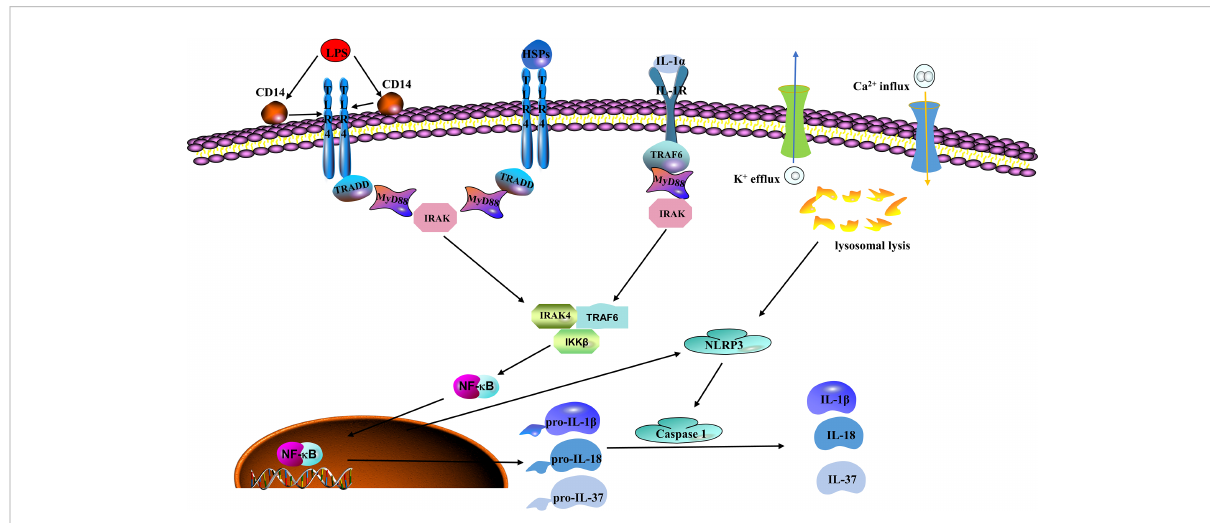
FIGURE 1 Classic mechanisms of in fl ammasome activation. Lipopolysaccharide (LPS), which is regarded as the prototype of pathogen associated molecular patterns (PAMPs) and heat shock proteins (HSPs) as a typical representative of damage associated molecular patterns (DAMPs), can be recognized by toll-like receptor 4 (TLR4). Nuclear factor kappa B (NF k B) mediates these signals to produce NOD-like receptor family pyrin domain containing 3 (NLRP3), pro-IL-1 b , pro-IL-18, and pro-IL-37. Next, NLRP3 is activated by potassium (K+) ef fl ux, calcium (Ca2+) in fl ux, and lysosomal leakage to recruit cysteine-requiring aspartate protease-1 (caspase-1). Caspase-1 then induces the maturation and release of pro-IL-1 b , pro-IL-18, and pro-IL- 37 and other related in fl ammatory agents that cause the in fl ammatory reaction and participate in the occurrence and development of the